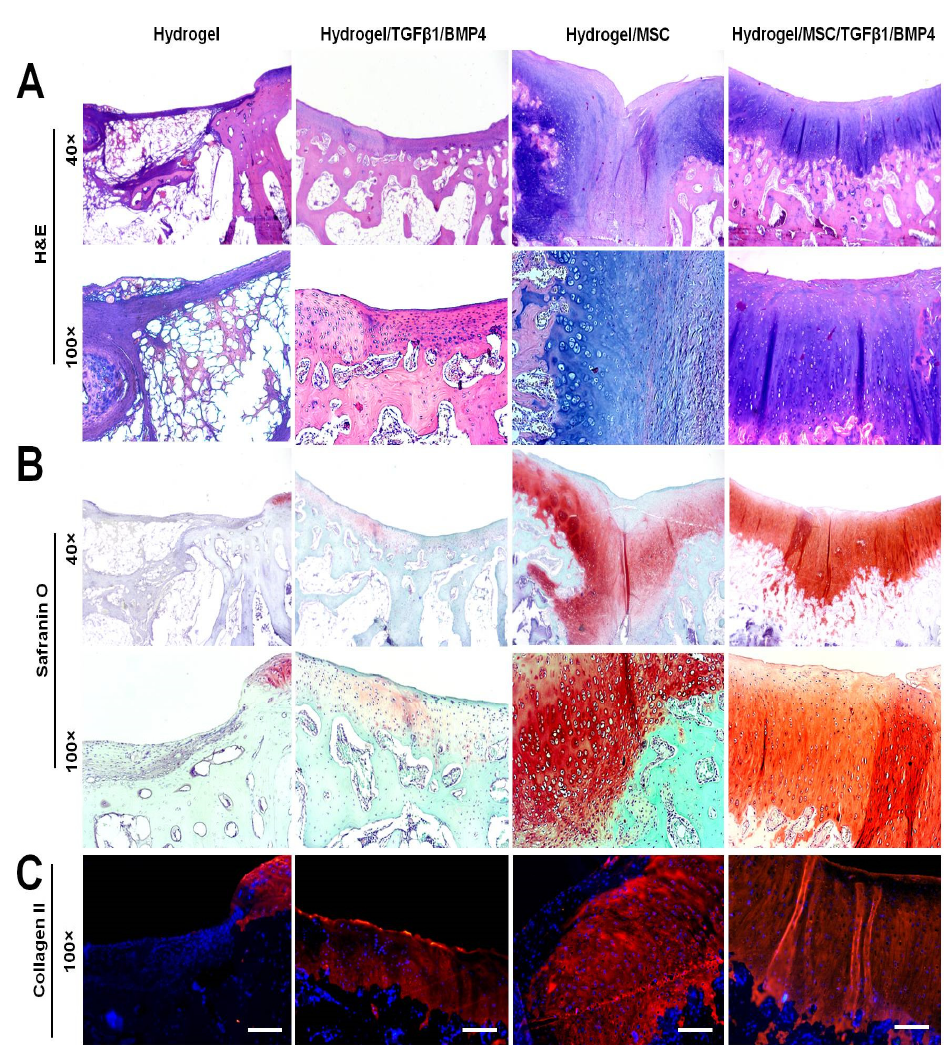
Figure 6. Histological analysis of the osteochondral defect repair at week 12 after hydrogel implan- tation. ( A ) H&E staining; ( B ) Safranin O staining; ( C ) Immunohistochemical staining of collagen II (red). Cell nuclei are stained with DAPI (blue). Scale bar, 100 μ m.